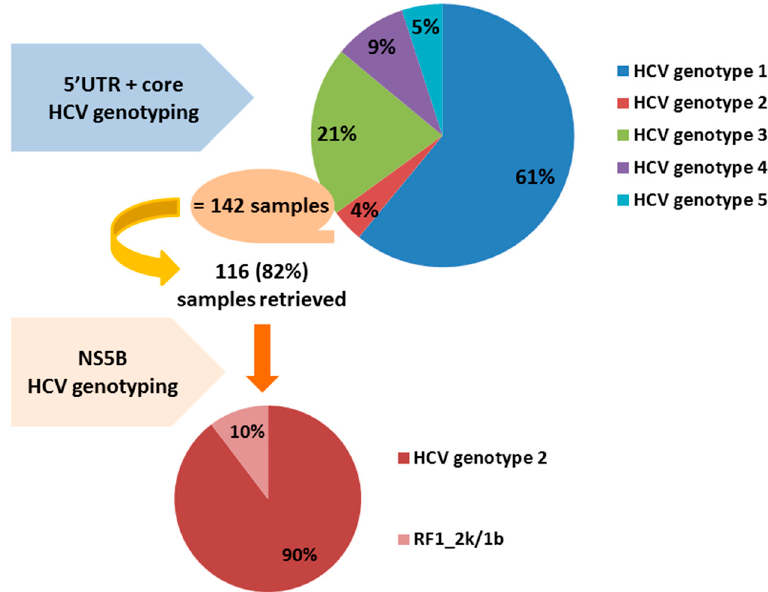
Figure 1. Summary of the results obtained: 12 out of the 116 HCV genotype 2 samples retrieved or 10% were classified eventually as RF1_2k/1b by sequencing of the NS5B region. RF1_2k/1b: recombinant form 2k/1b; HCV: hepatitis C virus; UTR: untranslated region; NS5B: nonstructural protein 5B.